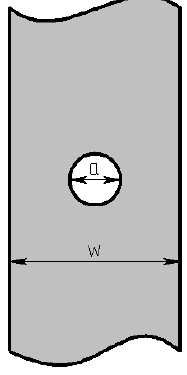
Fig. 4. Defect – circular